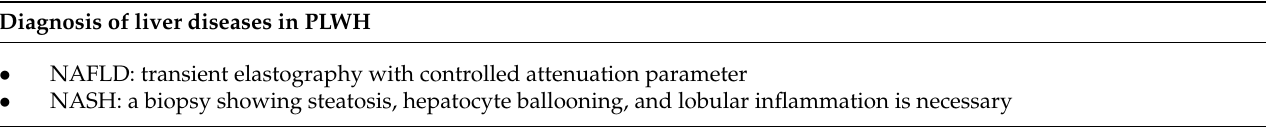
Table 4. Overview of diagnosis and nutritional management of liver diseases in